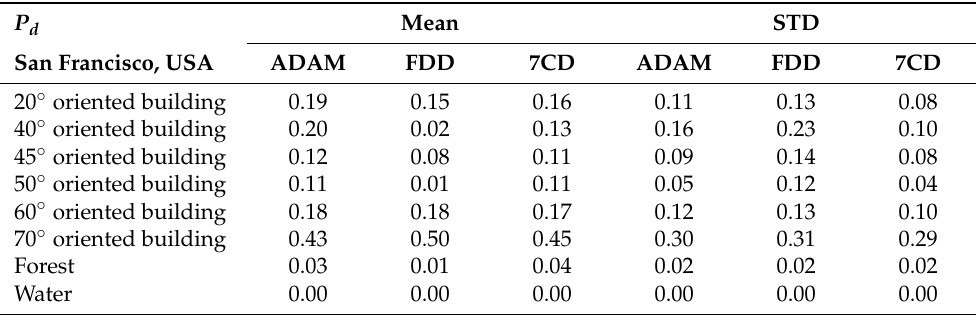
Table 4. The statistical results of double-bounce scattering power P d in 8 types of samples over San Francisco, USA.